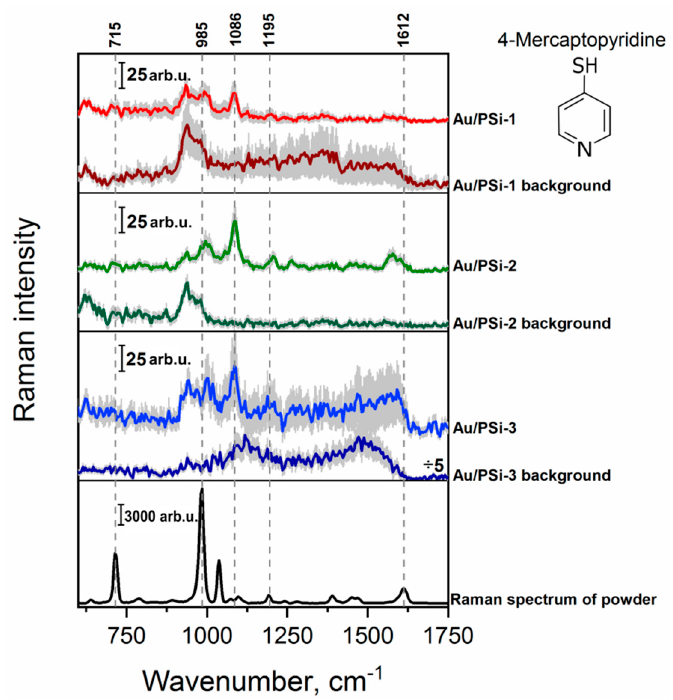
Figure 4. Raman spectrum of 4-Mpy powder and mean SERS spectra of 5 × 10 − 6 M concentration of 4-MPy on the surfaces with different morphology: Au/PSi-1, Au/PSi-2 and Au/PSi-3. Error scale bar (shown as grey shadow) for all presented spectra indicates the standard deviations from around 1500 measured spectra from three different areas of the substrate.